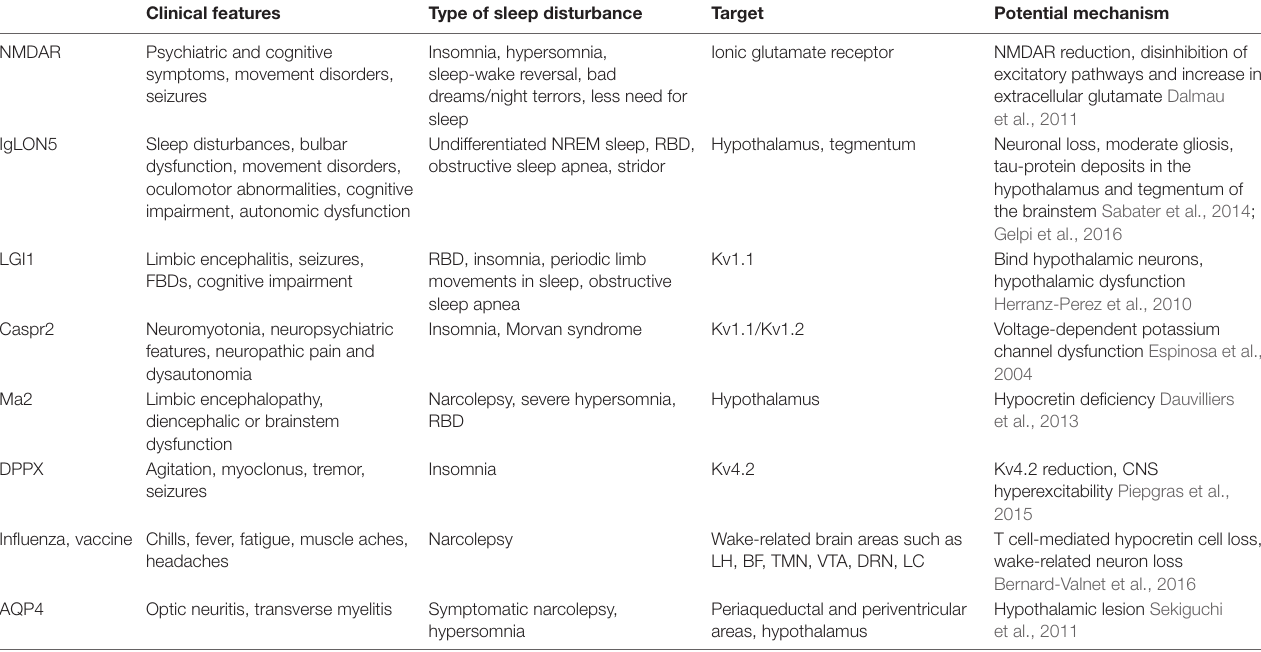
TABLE 1 | Clinical features, type of sleep disturbances, targets, and potential mechanisms of autoimmune neurologic